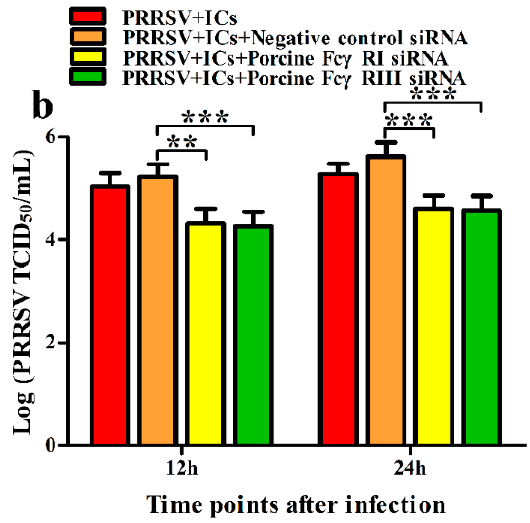
Figure 5. Effect of Fc γ RI or Fc γ RIII knockdown on ADE activity of PRRSV infection in PAMs. PAMs cells were transfected with porcine Fc γ RI or Fc γ RIII siRNA for forty-eight hours and then infected by PRRSV + ICs for the indicated time. The RNA levels ( a ) and the virus titers ( b ) of PRRSV in cell supernatants harvested were evaluated by real-time RT-PCR and TCID 50 assay. *** p < 0.001, ** p < 0.01.